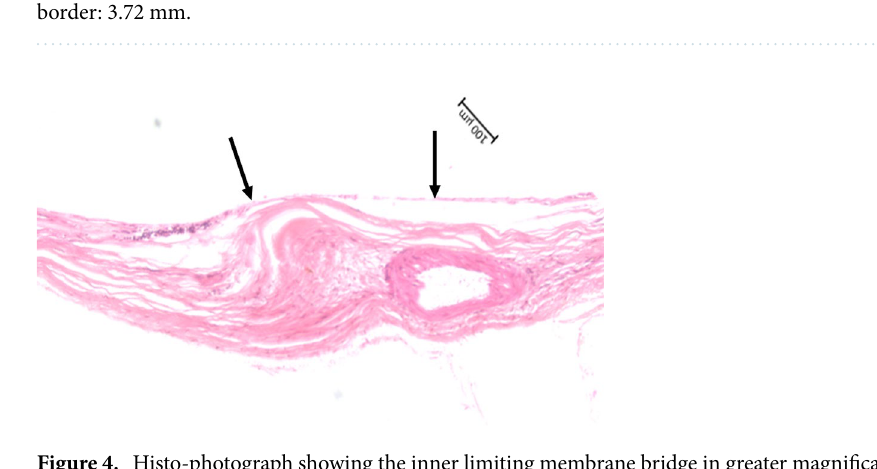
Figure 4. Histo-photograph showing the inner limiting membrane bridge in greater magnification (between black arrows), with few cells attached to the inner limiting membrane.